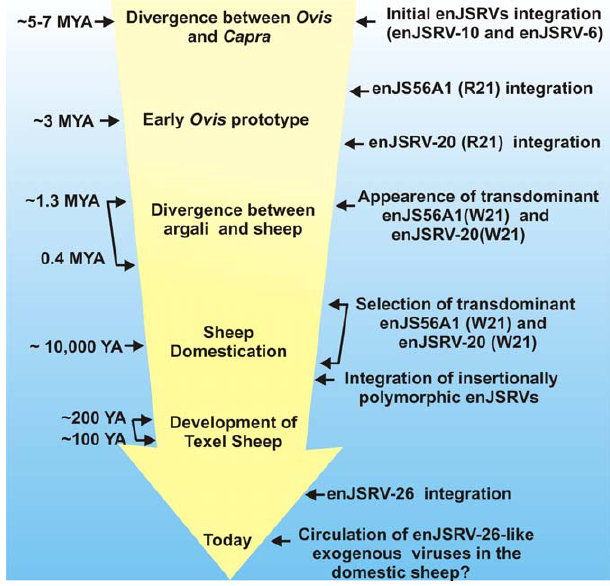
Figure 7. Dates and Events Associating the Evolutionary History of enJSRVs and Their Host Schematic diagram illustrating key events of the evolutionary history of enJSRVs described in this study in association with estimated dates during the evolution of the domestic sheep and the Caprinae.